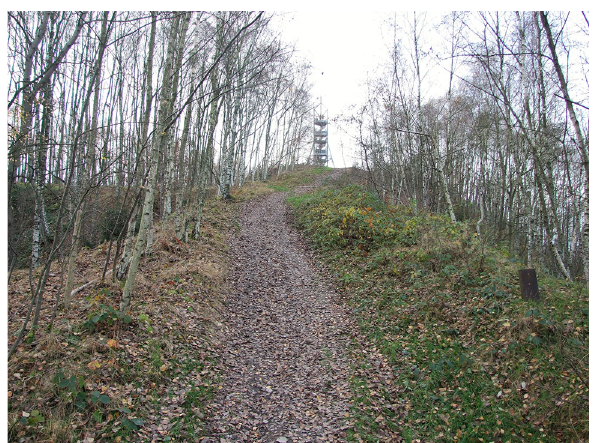
Fig. 2 Hiking trail and viewing tower on the former coal-mining dump ‘Deutschlandschachthalde’ in Oelsnitz (photo: Bieberstein/